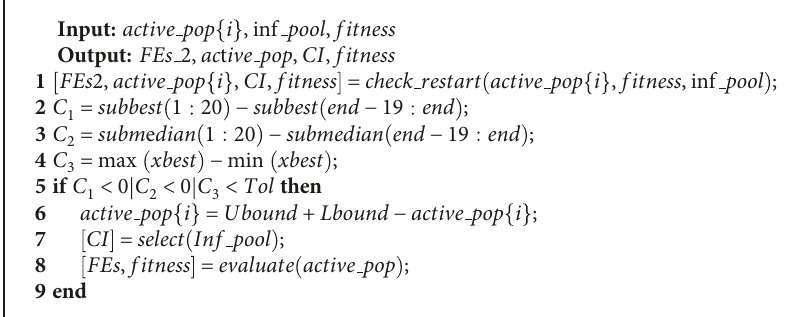
Algorithm 4: Check Stagnation and Restart.